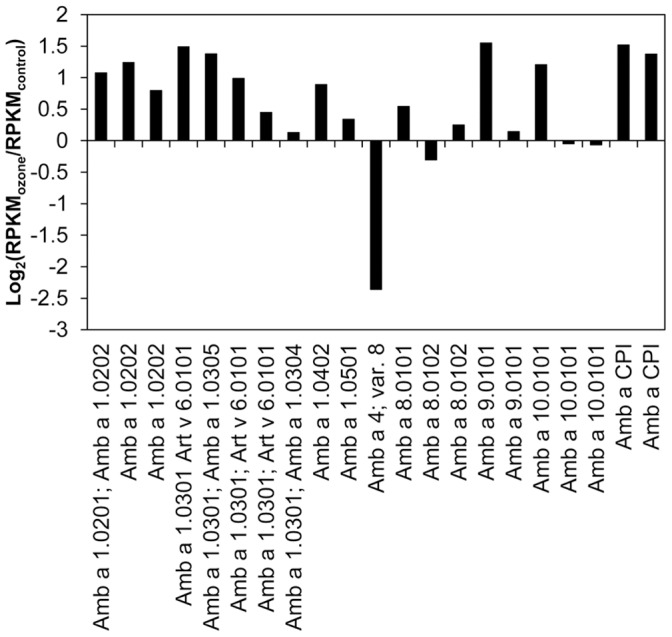
Log2-fold changes (RPKMozone/RPKMcontrol) of known Ambrosia artemisiifolia allergens.All data presented are isotig specific and normalized on RPKM.